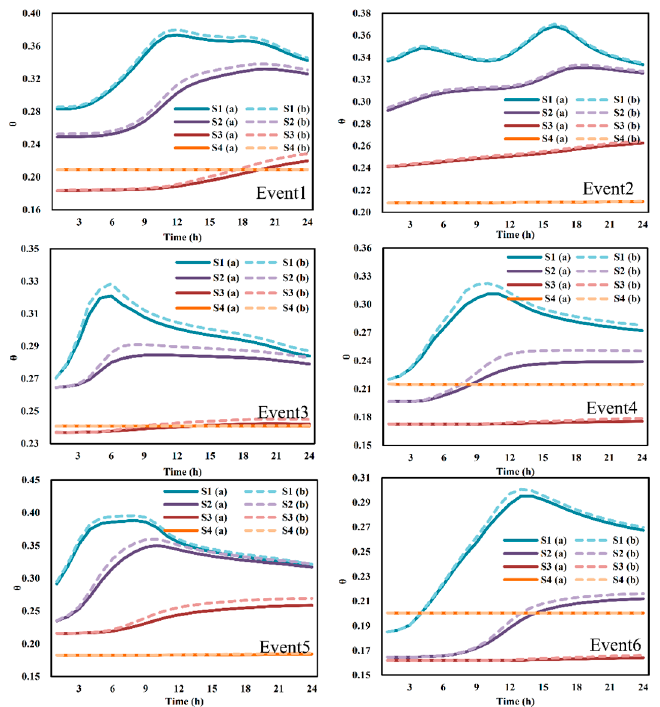
Figure 11. Temporal variations of the grid average soil moisture in the four soil layers: (a) WRF-only; (b) the fully coupled WRF /